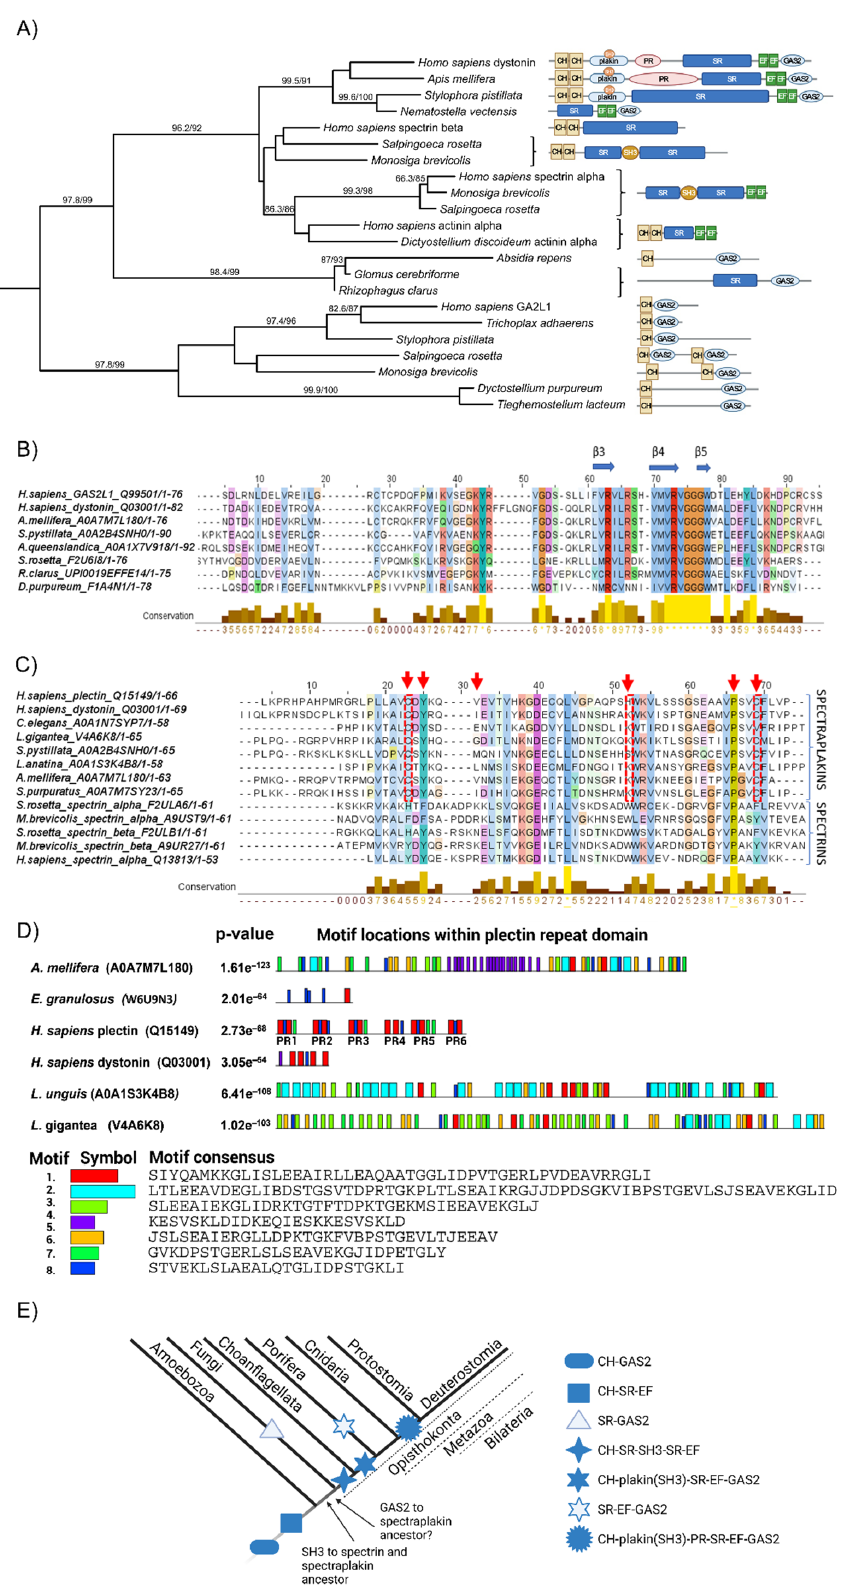
Figure 4. Analysis of spectraplakin proteins and domains in animals, and its closest relatives. ( A ) Phylogenetic relationship of different spectrin, spectraplakin, and GAS2 proteins. The